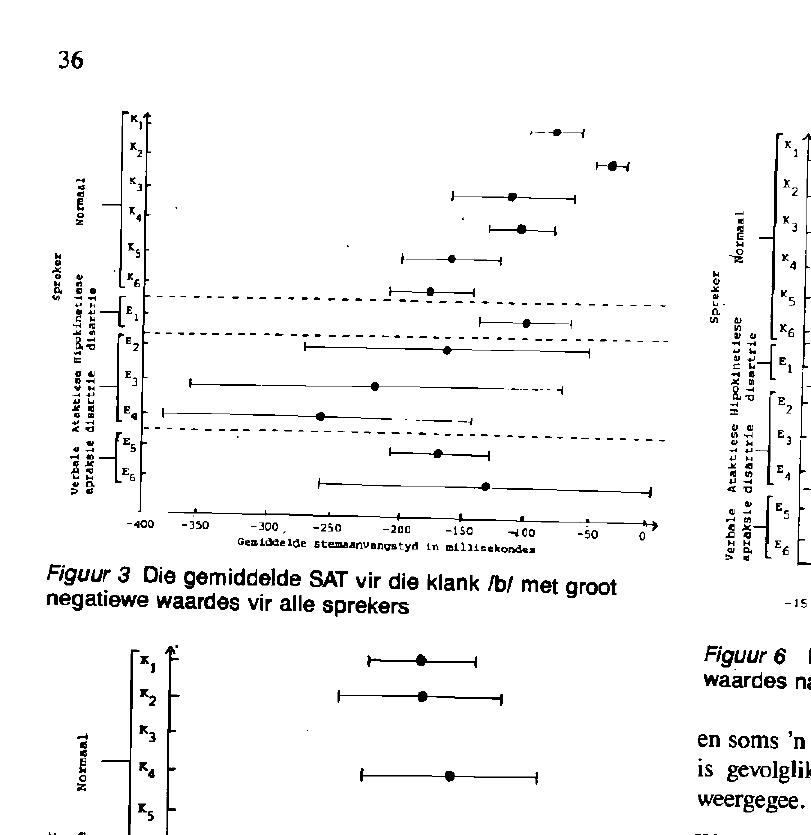
Figuur 4 Die gemiddelde SAT vir die klank /b/ met 'n waarde naby nul vir alle sprekers